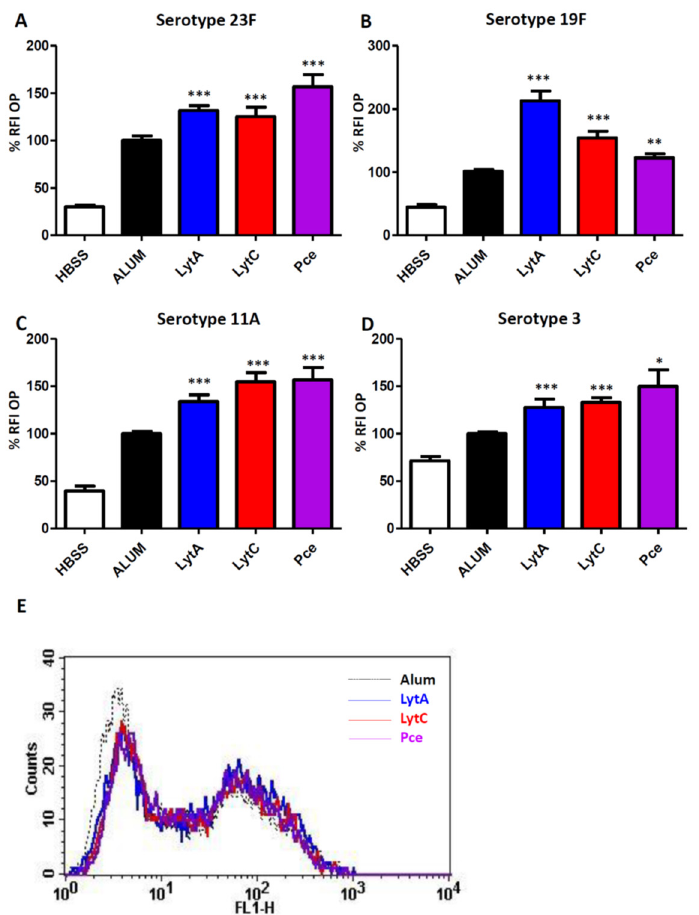
Figure 4. OP assays using the HL-60 neutrophil cell line and S. pneumoniae strains incubated with HBSS (white bar) or pooled sera from mice immunized with Alum (black bar) or with LytA-Alum (blue bars), LytC-Alum (red bars), or Pce-Alum (purple bars). ( A ) Strain 48 (serotype 23F). ( B ) Strain 69 (serotype 19F). ( C ) Strain 450 (serotype 11A). ( D ) Strain 957 (serotype 3). ( E ) Example of a flow cytometry histogram for OP of the clinical isolate of serotype 23F. Results are expressed as % RFI. Error bars represent the SDs and asterisks indicate statistical significance of LytA, LytC, or Pce immunization compared to the Alum group; * p < 0.05; ** p < 0.01; *** p < 0.001.